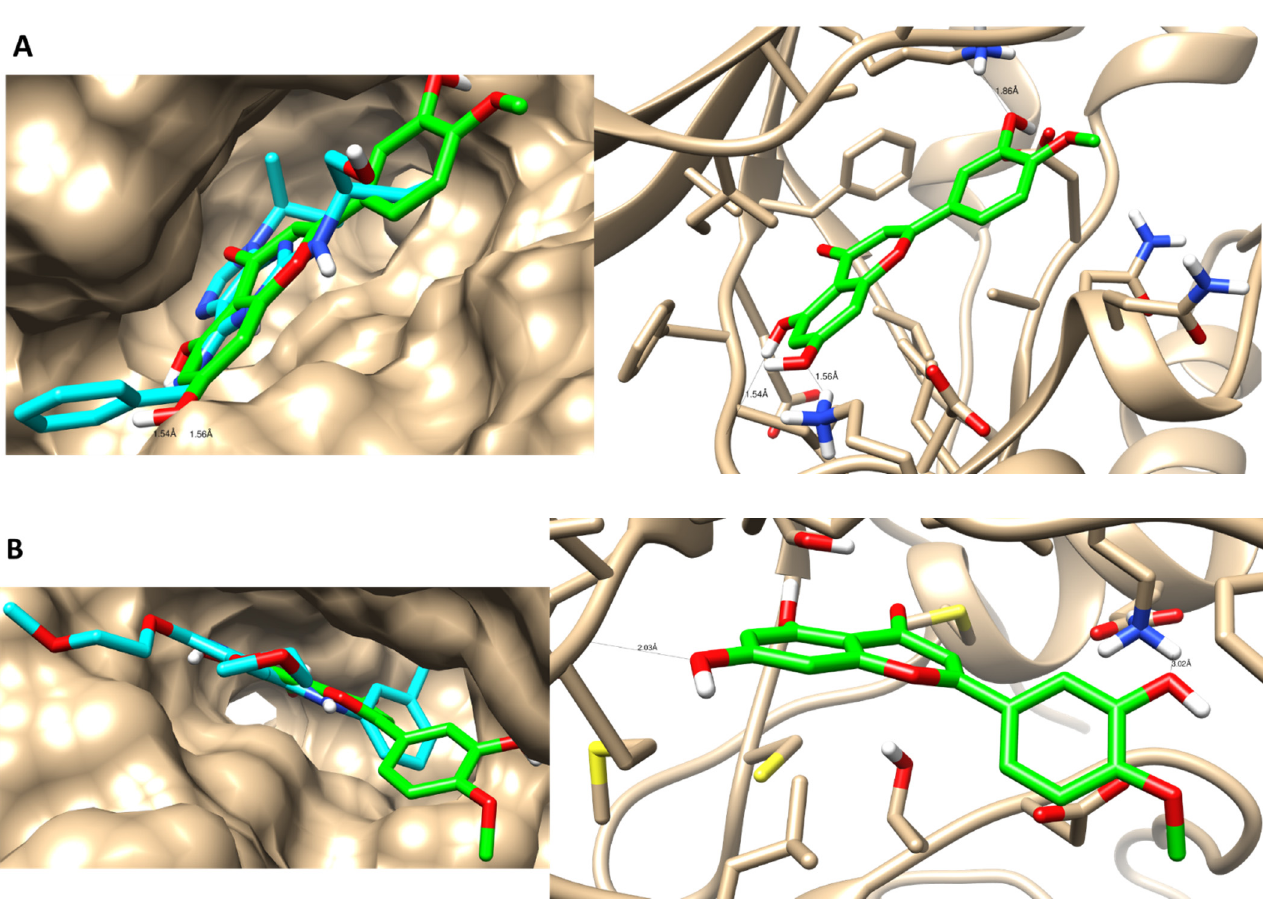
Figure 7. Binding disposition and ligand–receptor interactions of compound 14 inside the CDK-2 protein ( A ) and the EGFR protein ( B ). Left panel indicates surface representation, while the right panel indicates interactive mode. Three dimensional images were made using Chimera software.